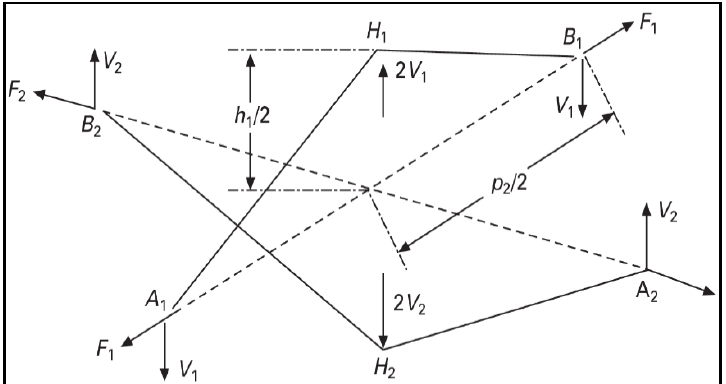
Figure 5. Saw tooth model for plain weave. (A 1 , A 2 , B 1 , B 2 : are nodal points of the saw tooth model, H 1 , H 2 : are crimp amplitudes in X and Y axes, h 1 /2: crimp height from crossover point, F 1 , F 2 : Total force along the saw tooth axes, p 2 /2: half wavelength, V 1 , V 2 : inter yarn pressure)